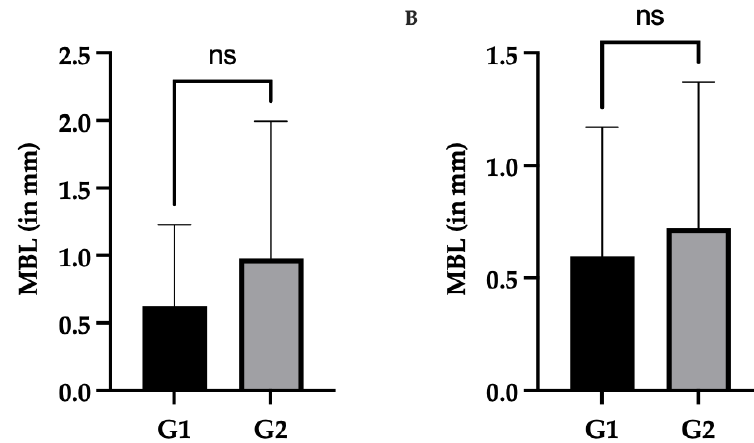
Figure 2. Marginal bone loss (MBL) in G1 (no bone augmentation) and G2 (bone augmentation) ( A ) all patients included in the study; ( B ) patients with peri-implantitis excluded. Error bars shown in this figure are means ± SD. The abbreviation non-significant (ns) is used for statistically nonsignificant, satistically significant at p ≤ 0.05.